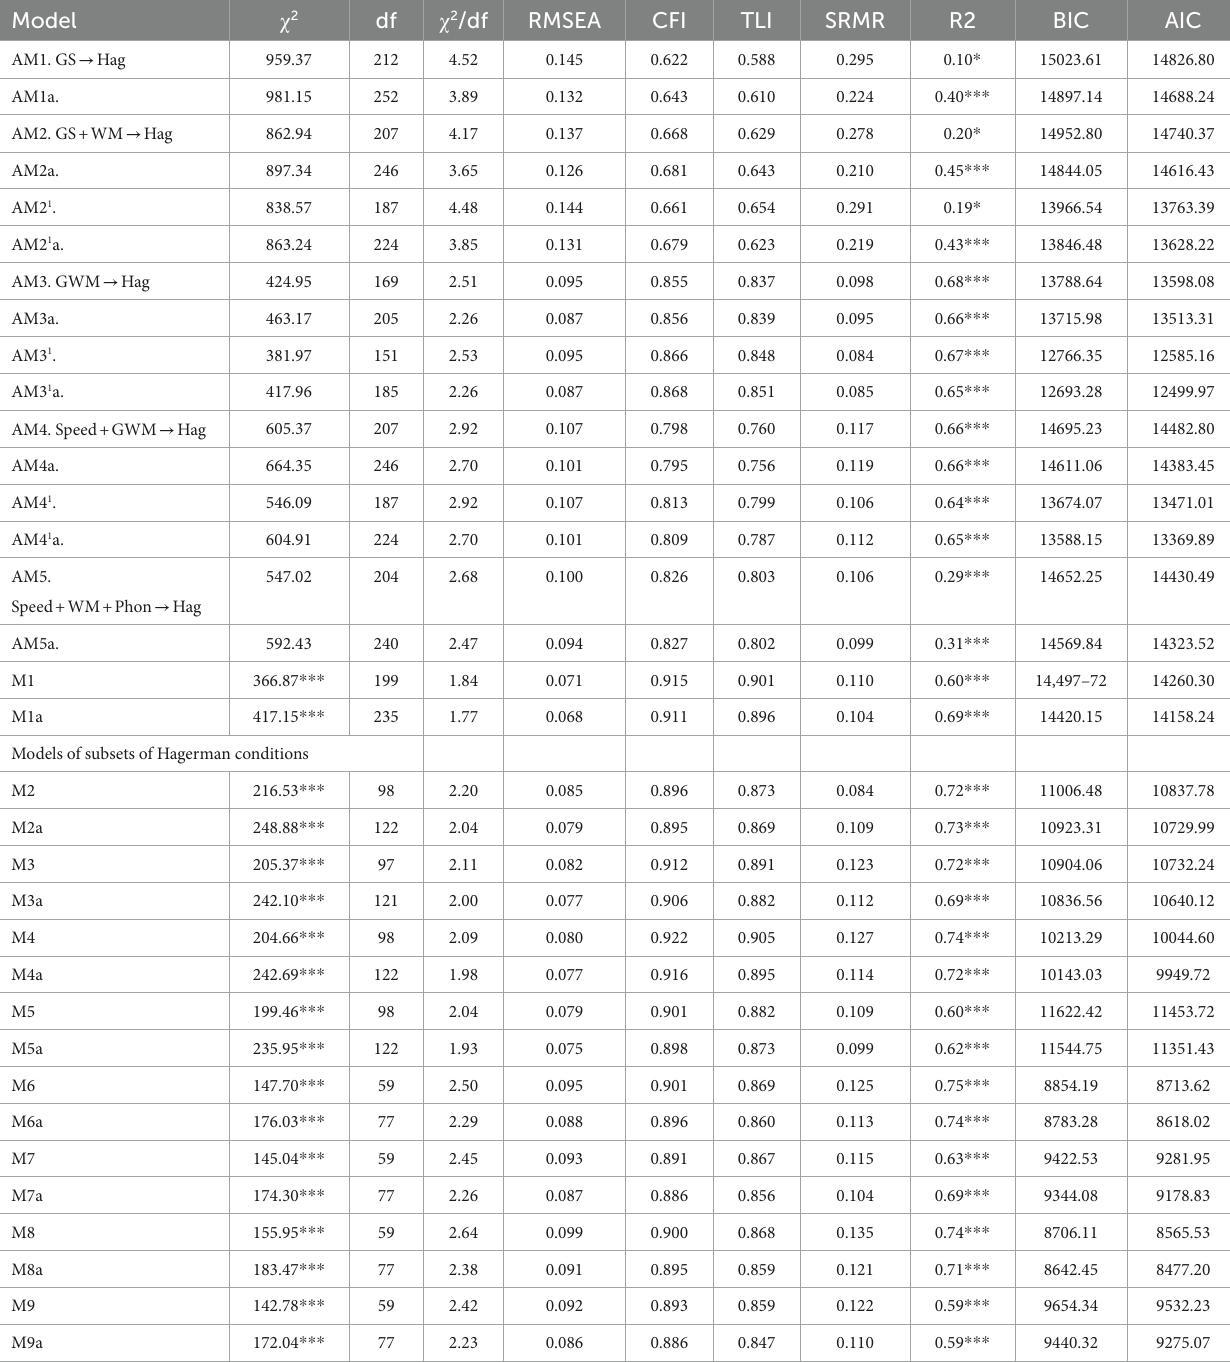
TABLE 1 Model fit indices of competing alternative models.